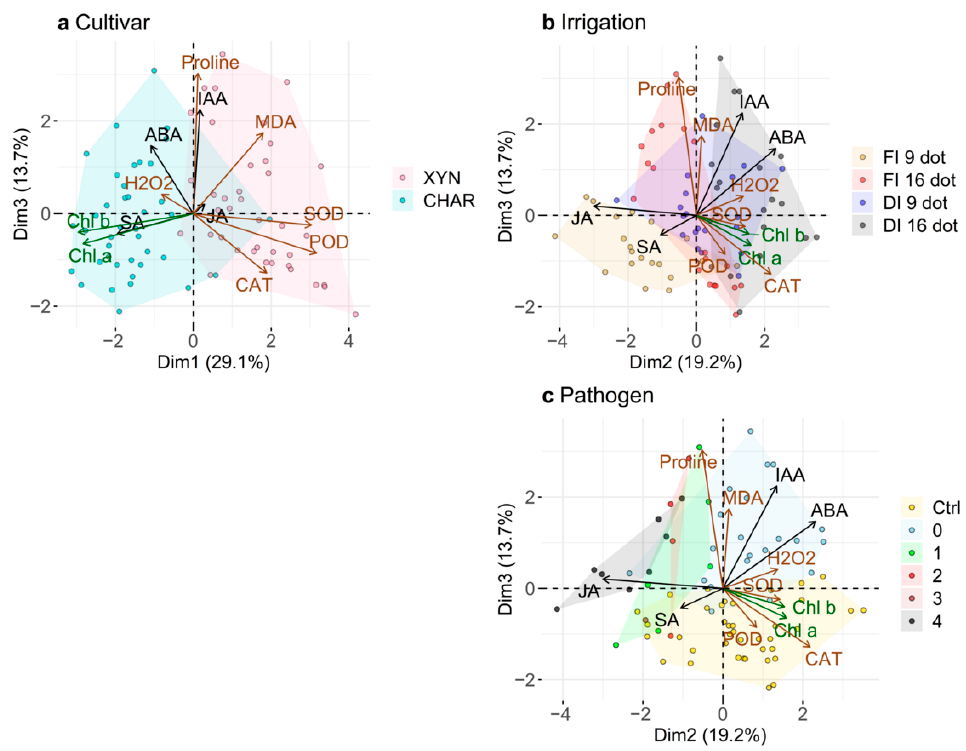
Figure 7. Principal component analysis visualizing the patterns in the phytohormone balance, oxidative balance, and chlorophyll content. Phytohormones are indicated with black arrows, oxidative parameters with brown arrows, and chlorophyll with green arrows. All plants (treated with continued exposure to full/deficit irrigation; see Figure 1) are represented by dots. Grouping is performed according to ( a ) cultivar: drought-tolerant Xynisteri (XYN) or drought-sensitive Chardonnay (CHAR); ( b ) drought stress: full (FI) or deficit (DI) irrigation and duration, at 9 or 16 days of irrigation treatment (dot); ( c ) pathogen stress: water-inoculated (Ctrl), no symptoms (0), oil spots (1), light sporulation (2), spreading sporulation (3), and heavily diseased (4). The first, second, and third principal components explained 29.1%, 19.2%, and 13.7% of the variation, respectively. Abbreviations: see Table 1. Along the horizontal axis (Dim2) in Figure 7c, the plants are separated according to disease severity, with symptomless plants on the right and the most diseased plants on the left. Upon clustering according to drought stress in the same dimensions (Figure 7b), the group showing no symptoms overlapped with the drought-stressed group. Resistance was primarily observed in the 1st quadrant since a majority of the plants in the 3rd and 4th quadrants were not inoculated with the pathogen. The diseased plants were mainly clustered in the 2nd quadrant. The PCA suggests that JA is associated with infection under full irrigation. Interestingly, this PCA indicates that ABA and IAA play a role in drought- induced resistance, in which JA is no longer involved.